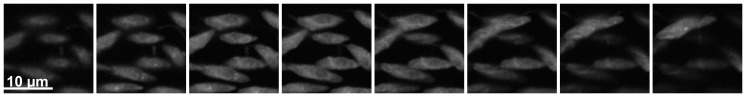
Mitochondrial morphology studied by laser scanning microscopy.PFA-fixed L. tarentolae promastigotes (Fig. 1A,B) were analyzed by laser scanning microscopy using a Zeiss LSM780 microscope and the software ZEN 2010. Z-stacks at Z increments of 0.41 µm are shown from left to right. A 458 nm laser served as a light source.